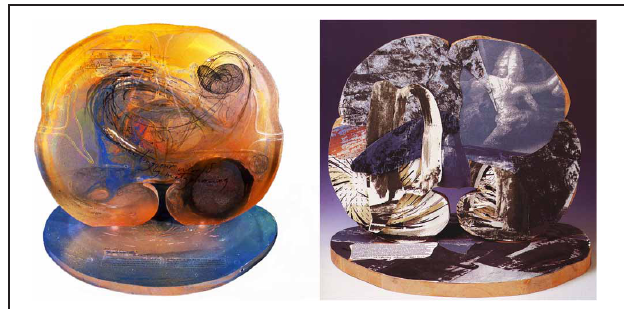
FIGURE 1 | Two examples of Todd Siler’s “Mind Icons,” rendered on frontal sections of the brain and alluding to the innumerable productions of the mind and complex structures of the brain. Left: “Connectivity” Siler (1975). Right: “Radical Futures” Siler